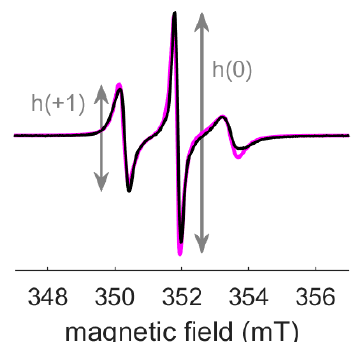
Figure 3. Experimental X-band cw EPR spectrum of nitroxide labeled protein (black trace) and its sim- ulation with an axial t corr (magenta trace). This spectrum is characterized by h(0)/h(+1) ≈ 2, where h(0) and h(+1) are the amplitude of the central and low field lines, respectively. Parameters for the sim- ulation: t corr,xz = 4.5 ns, t corr,y = 0.2 ns, g x = 2.0082, g y = 2.0061, g z = 2.0022, A xy = 0.42 mT = 11.8 MHz, A z = 3.70 mT = 103.7 MHz, at 9.9 GHz, no additional